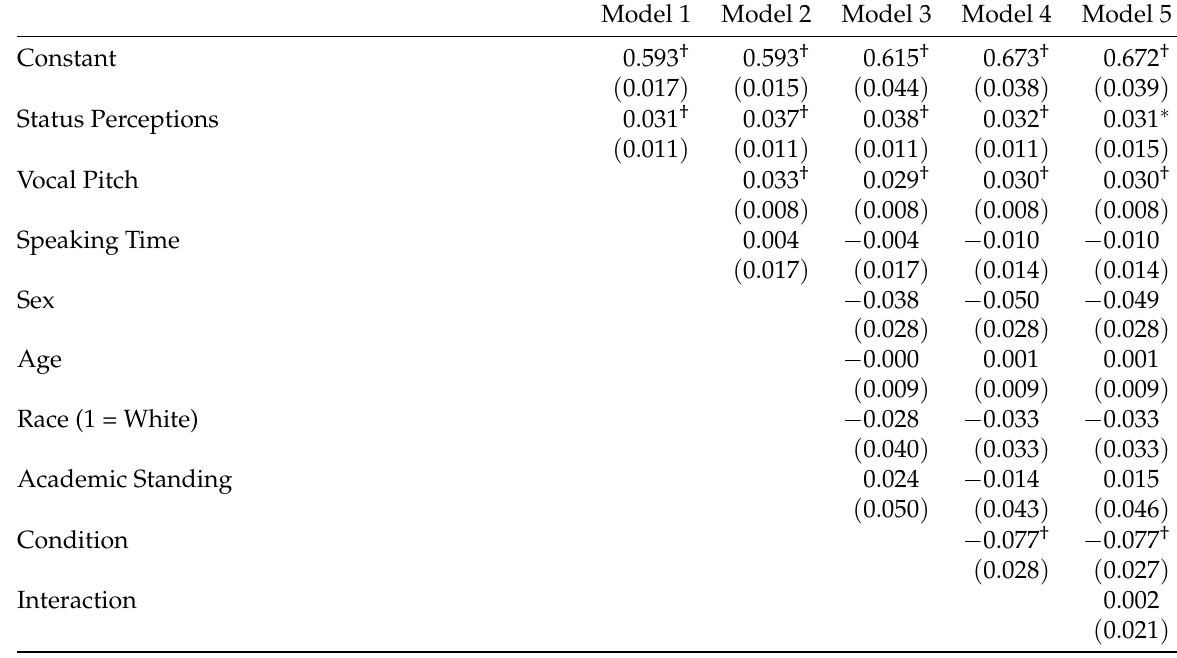
Table 6: GEE predicting vocal accommodation from subjective status perceptions ( N =